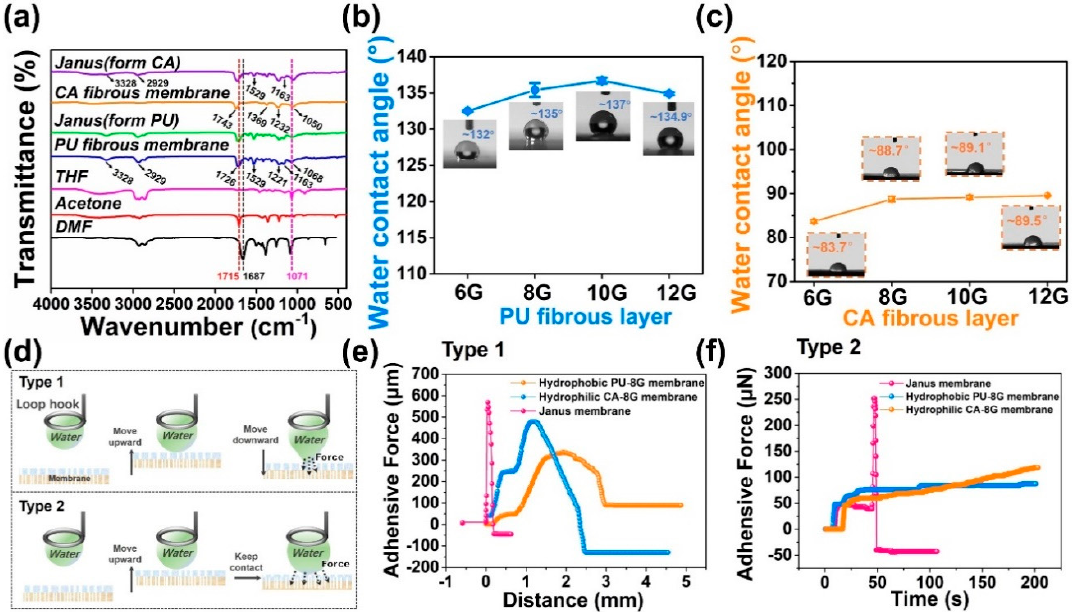
Figure 4. ( a ) Fourier transform infrared spectrometry (FTIR) spectrum of the PU, CA, Janus